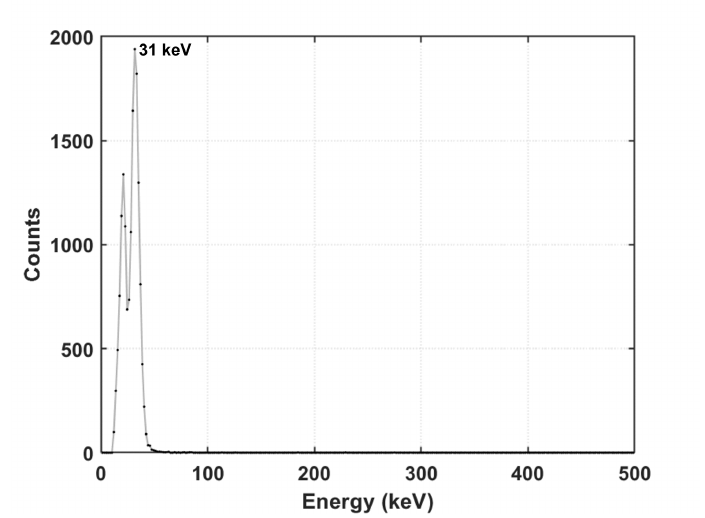
Figure 10. Spectrum resulting from the selection of events in the first depth region identified from the N / I parameter distributions ( N / I from 25 to 35).